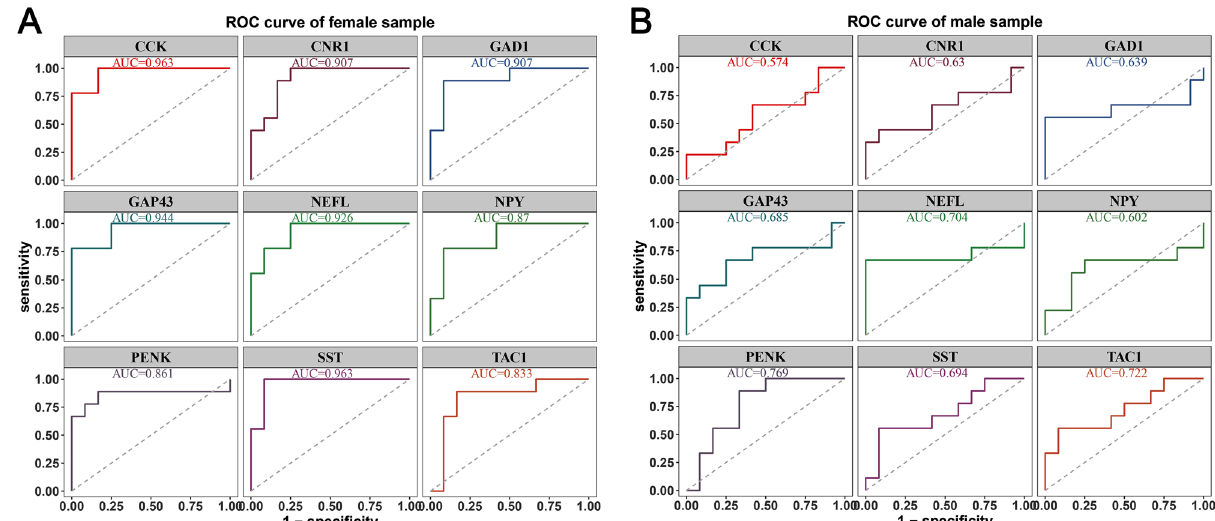
Figure 7. Gender-specific effect of 9 hub genes. The AUC values of 9 hub genes were greater than 0.7. The results demonstrated that 9 hub genes had high diagnostic accuracy in the female patients with AD. For the male patients, NEFL, PENK, and TAC1 were identified with high diagnostic accuracy with AUC values greater than